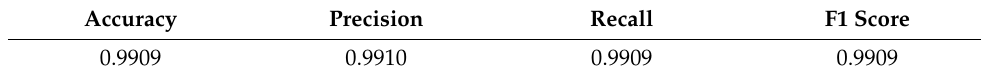
Table 6. LightGBM classification results on the test dataset.